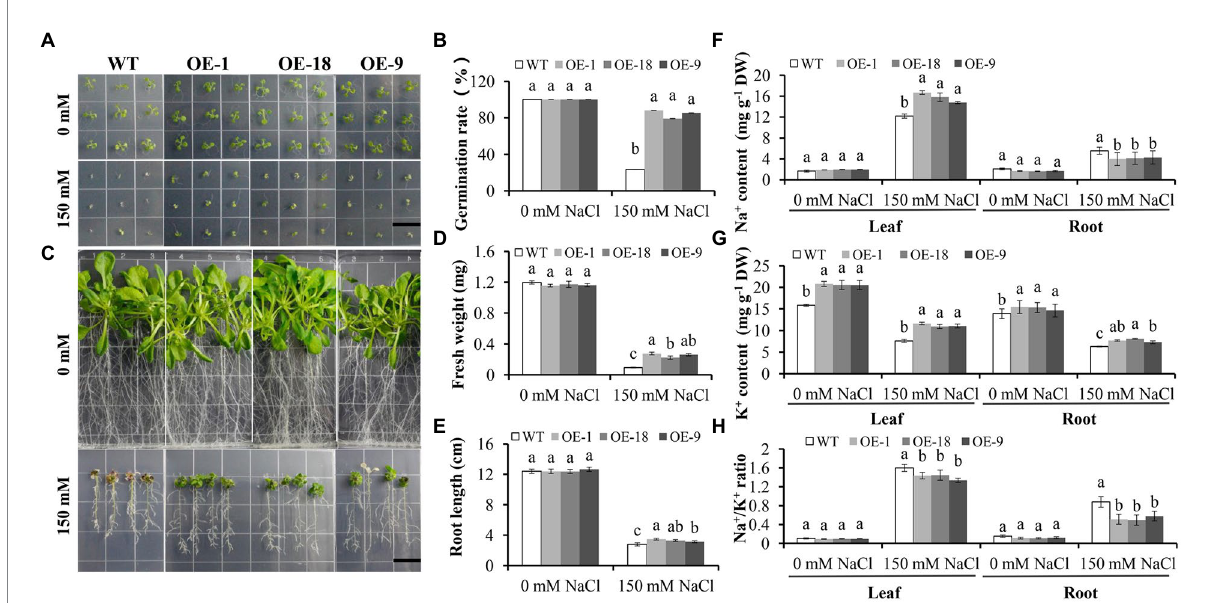
FIGURE 7 The effect of GmNHX6 overexpression on the salt tolerance of Arabidopsis . (A) Seed germination assay of different Arabidopsis lines on 1/2 MS medium supplied with 0 or 150 mM NaCl. Photographs were taken 7 days after treatment. WT: wild type; OE-1, OE-18, OE-9: Arabidopsis lines overexpressing GmNHX6 . Bar = 1.5 cm. (B) Seed germination rates of different Arabidopsis lines as shown in A. Data represents the mean ± standard deviation of three biological replications and each repeat contained 36 seeds per line for each treatment ( n = 36 × 3 = 108). (C) Arabidopsis seeds were grown vertically on 1/2 MS agar plates supplemented with 0 or 150 mM NaCl treatment for 10 days after 7 days of normal growth, respectively. Bar = 1.5 cm. (D,E) The fresh weight and root length of Arabidopsis lines shown in (C) . Data represents the mean ± standard deviation of three biological replications and each repeat contained four plants per line for each treatment ( n = 12). (F) Na + content, (G) K + content, (H) Na + /K + ratio in the leaves and roots of Arabidopsis lines shown in (C) . For (F–H) , data represents the mean ± standard deviation of three biological replications and each replication has four repeats ( n = 12), and 10 plants were pooled together for each sample. Bars with the same letter in lowercases above bars indicate no significant differences at the 0.05 level between lines under each condition according to Duncan’s multiple range